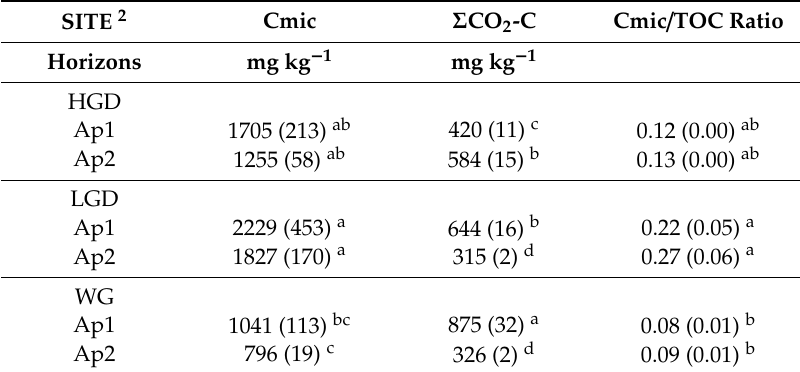
Table 4. Content of microbial biomass C, amount of CO 2 evolved during basal respiration experiments, and Cmic / TOC ratio of soils with high and low geese density, and of the soil of the control vineyard. Numbers in parentheses are the standard errors ( n = 2). SITE 2 Cmic Σ CO 2 -C Cmic / TOC Ratio Horizons mg kg − 1 mg kg − 1 HGD Ap1 1705 (213)